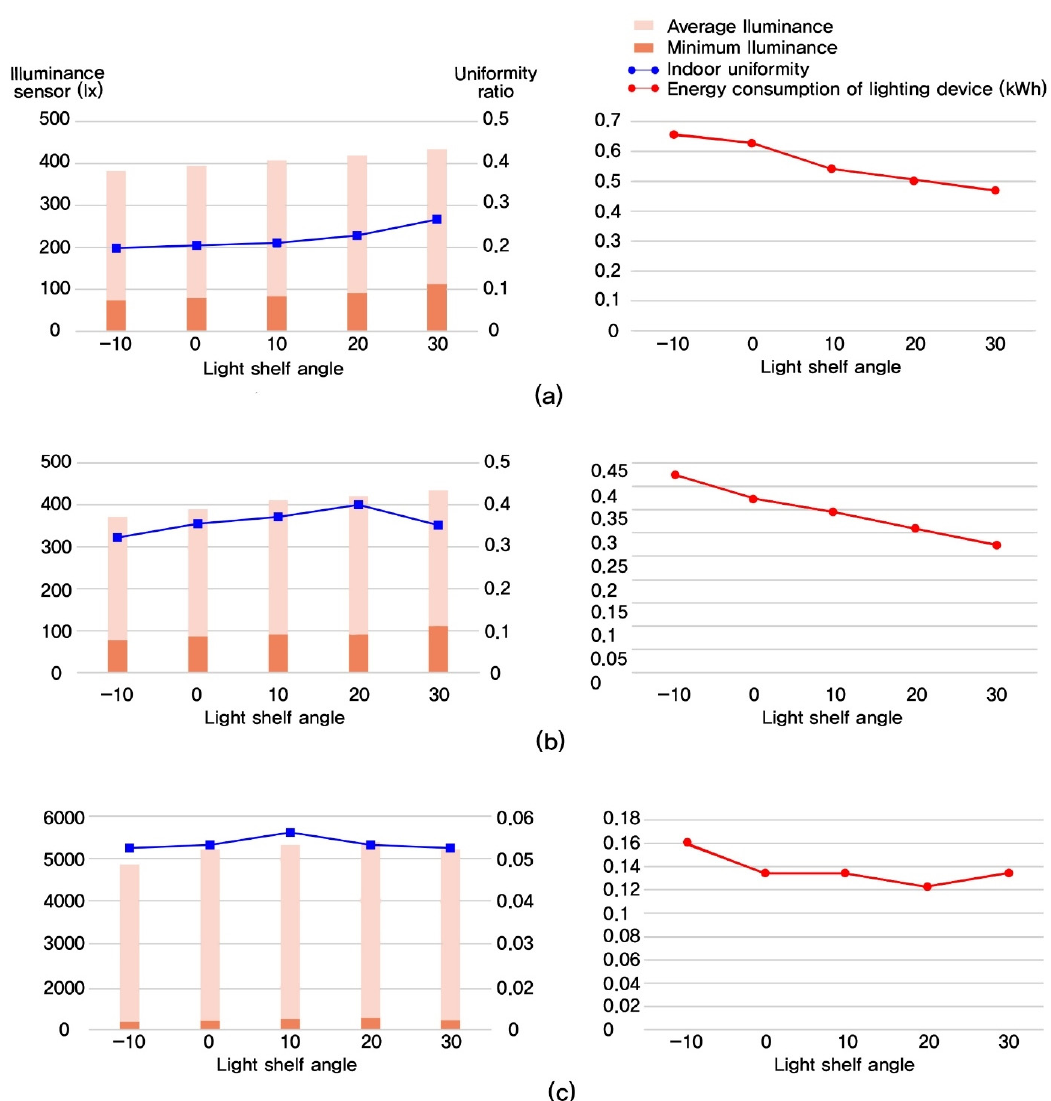
Figure 8. Indoor uniformity and lighting energy consumption according to the light shelf angle in Case 1: ( a ) Summer, ( b ) Middle season, ( c ) Winter.